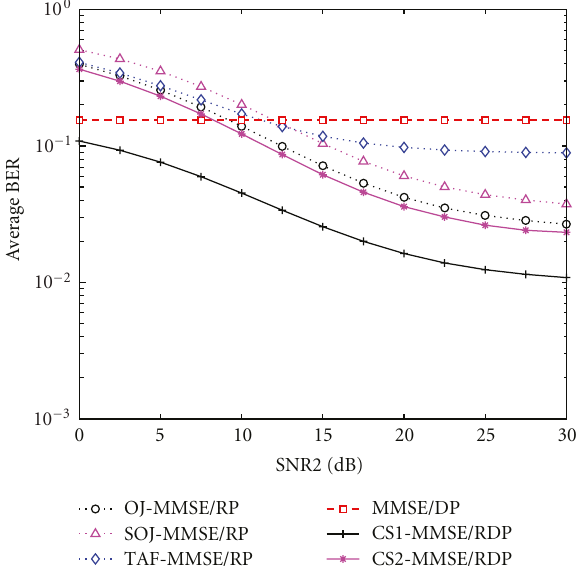
Figure 6: BER versus SNR of MS-RS link in uplink ( p = 0 . 4, SNR1 = 15dB)